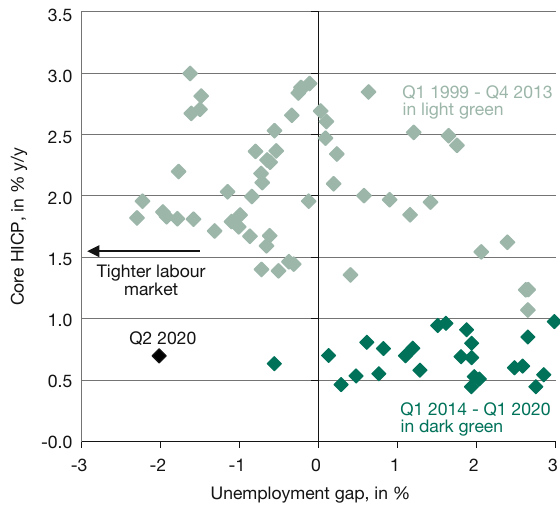
Source: Haver Analytics.